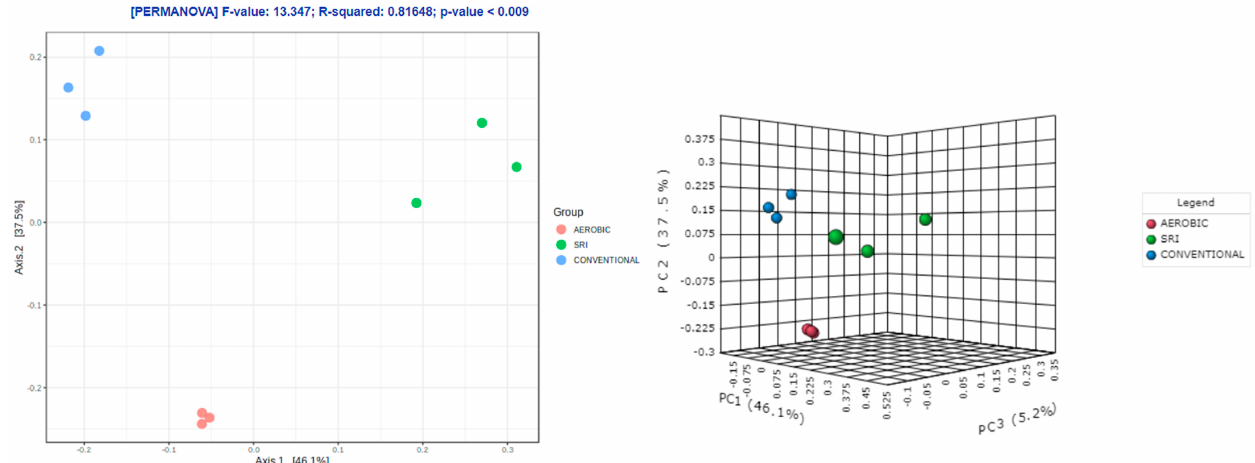
Figure 4. Two-dimensional ( left side ) and three-dimensional ( right side ) dot plot represents the beta diversity index of different types of rice planting systems.